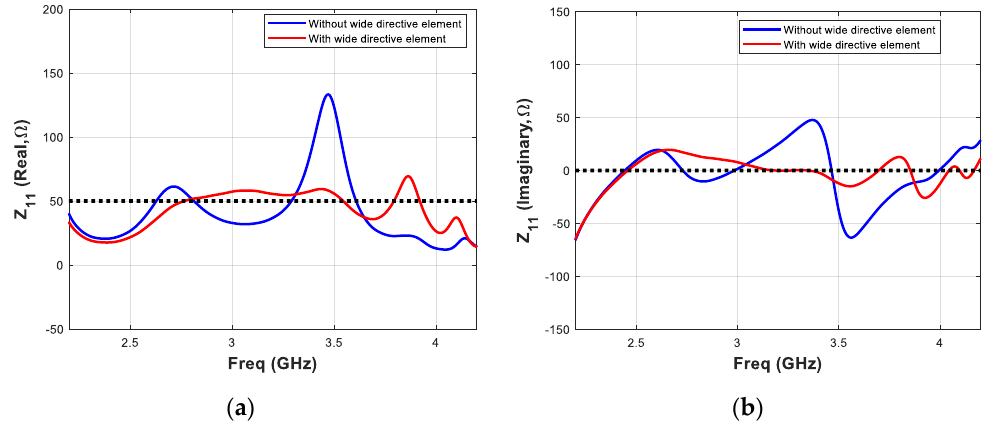
Figure 5. Comparison of ( a ) input impedance (real) and ( b ) input impedance (imaginary) parameters of the proposed antenna element, without and with tightly coupled wide directive element.